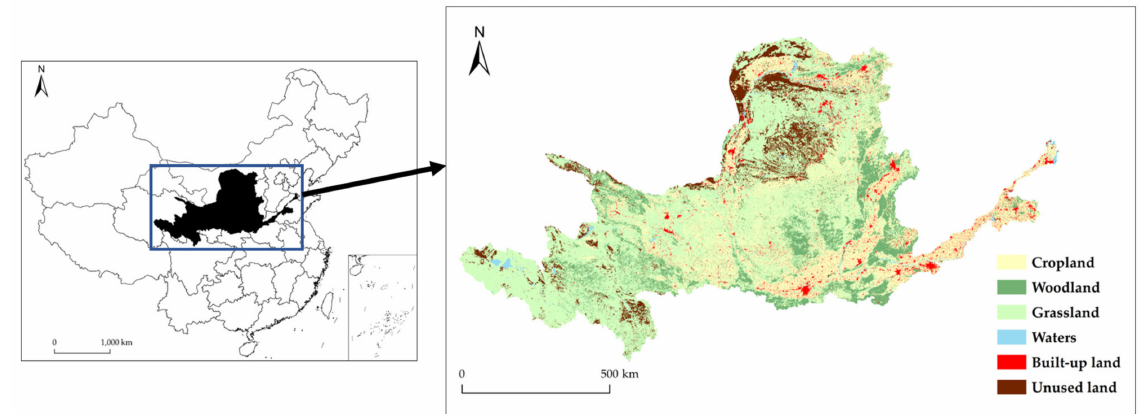
Figure 1. Map of land use types in the Yellow River Basin